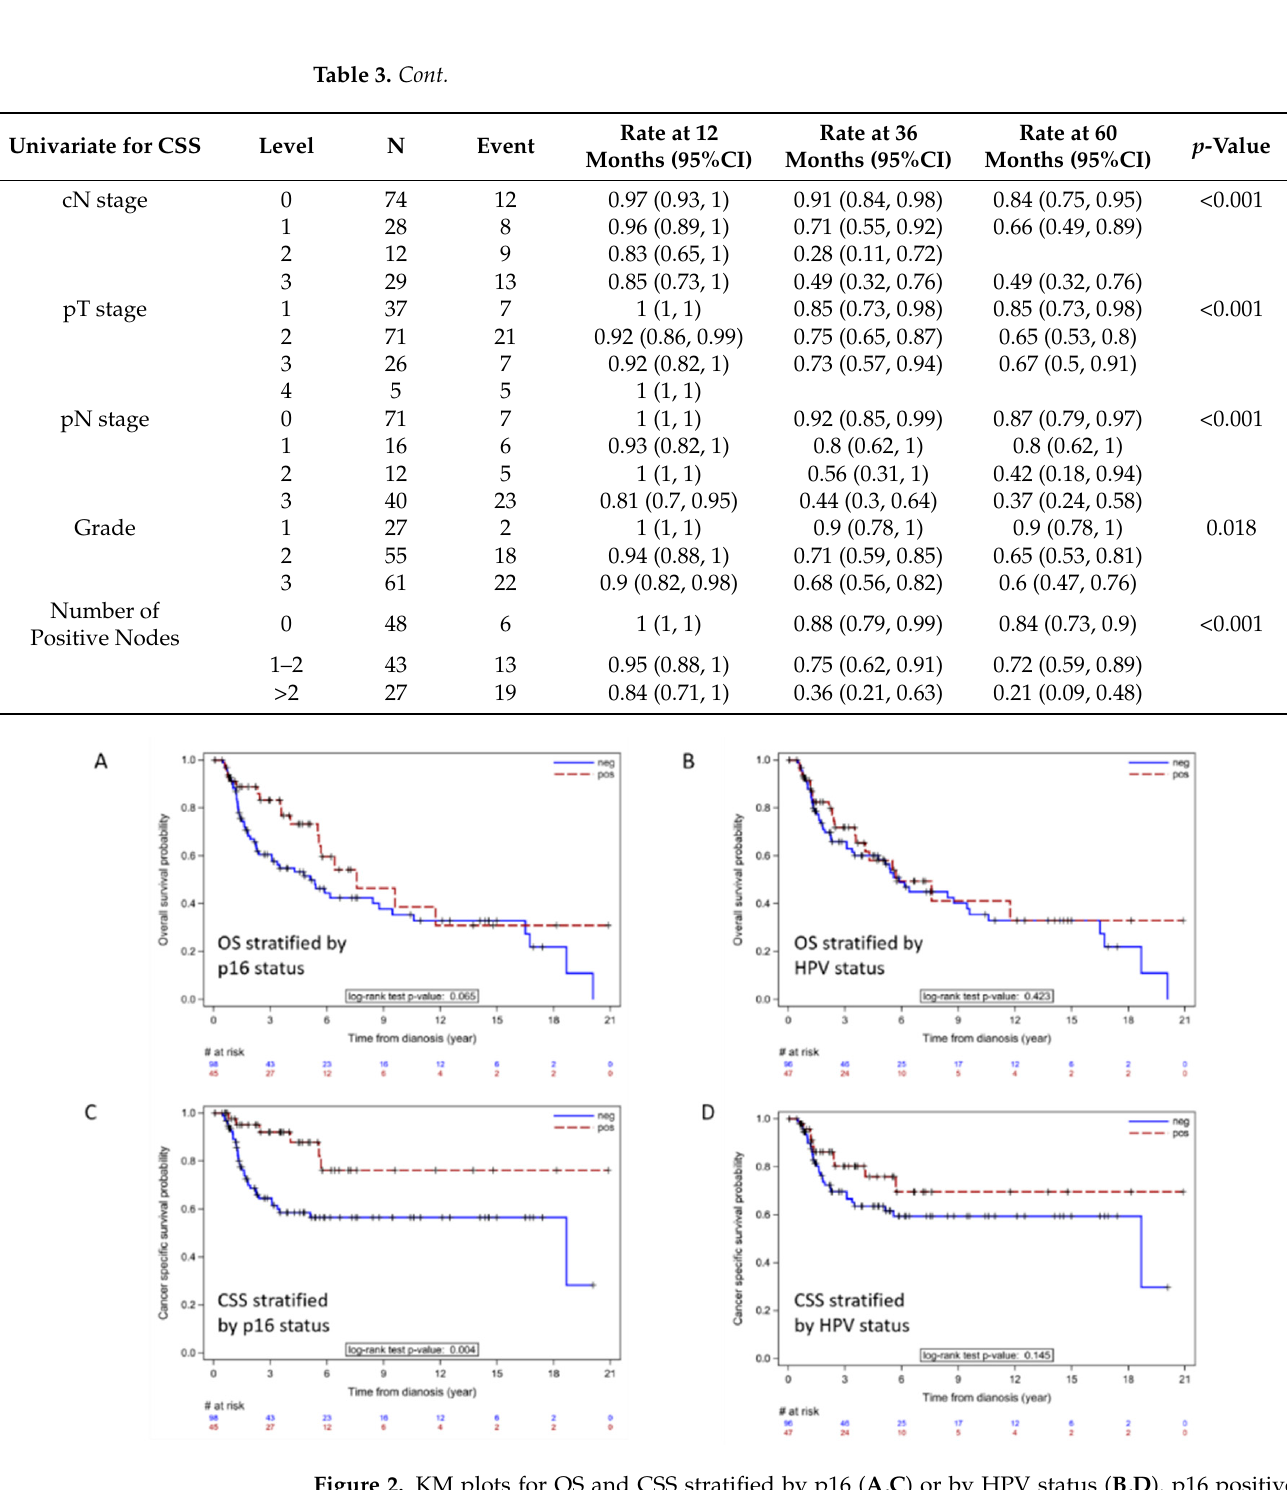
Figure 2. KM plots for OS and CSS stratified by p16 ( A , C ) or by HPV status ( B , D ). p16 positive patients have better overall CSS ( p = 0.004) than p16 negative patients.